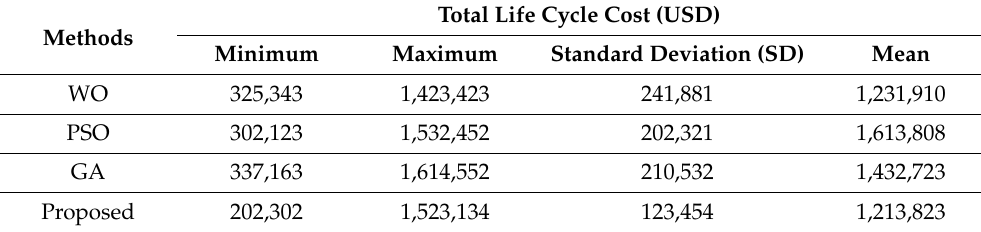
Table 1. Comparative results of total life cycle cost.